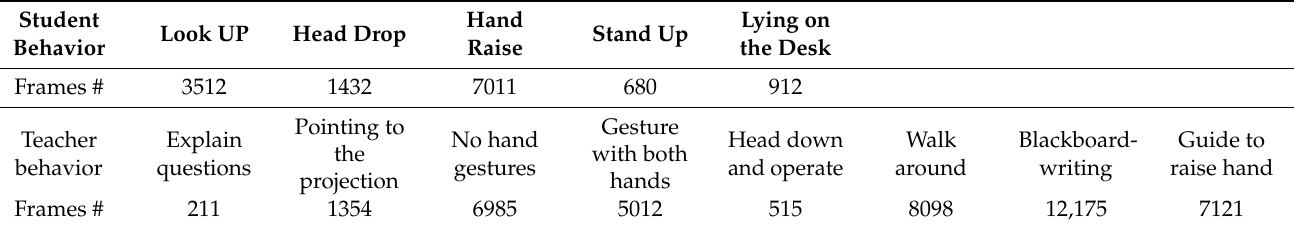
Table 1. Statistics of the Experiment